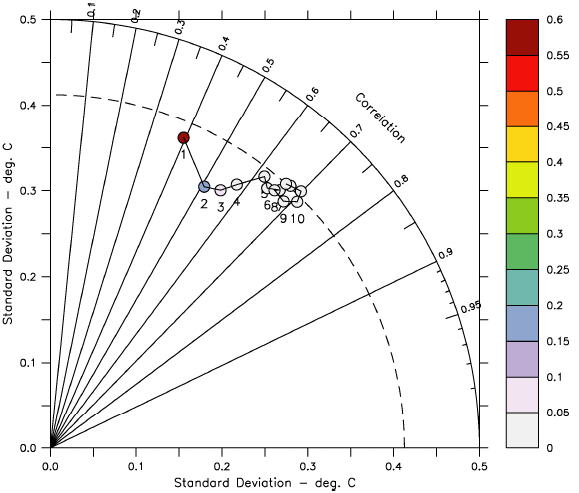
Fig. 6. Taylor diagram of the convergence of SST in the RELX ex- periment. The radial position is the standard deviation of the dif- ference between the annual SST and the guide field for each year of the experiment (in ◦ C). The angular position gives the correla- tion of SST difference fields with the field of the following year, so point “5” is the correlation of SST from years 5 and 6. A perfectly correlated (or anti-correlated) field would appear somewhere on the x -axis on the Taylor diagram, a completely uncorrelated field would be on the y -axis. The value of the difference in the average for the Australian region to the average of the final year ( ◦ C) is represented by the colour of each